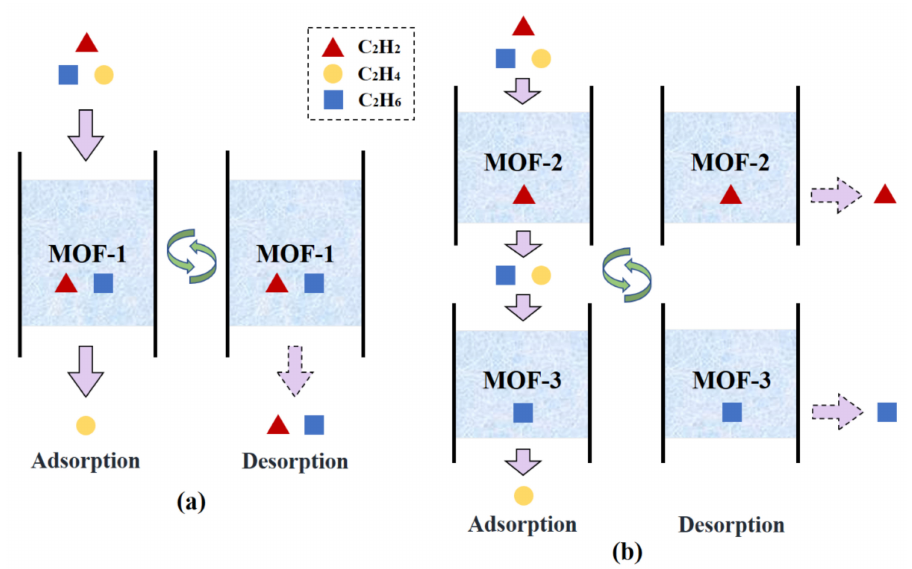
Figure 5. Schematic diagram of two adsorption process configurations for the separation of the